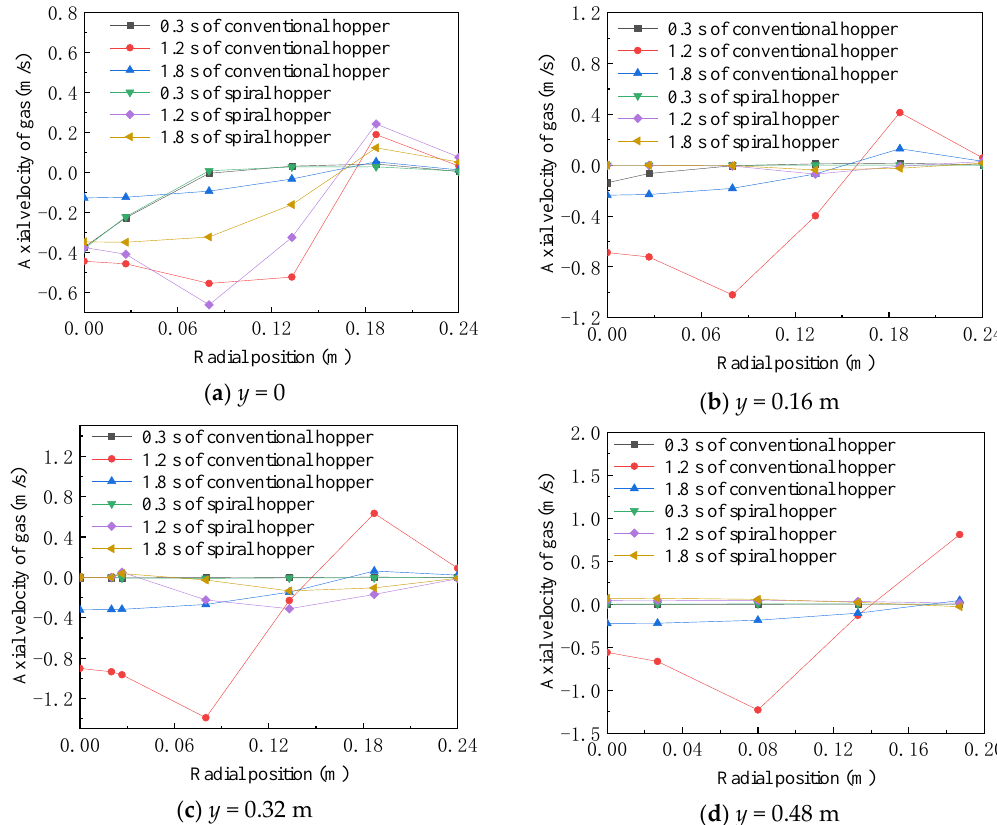
Figure 7. CFD results show gas axial velocity of different time at the cross-section of ( a ) y = 0; ( b ) y = 0.16 m; ( c ) y = 0.32 m; ( d ) y = 0.48 m. y is the distance from the hopper inlet to the cross-section of the